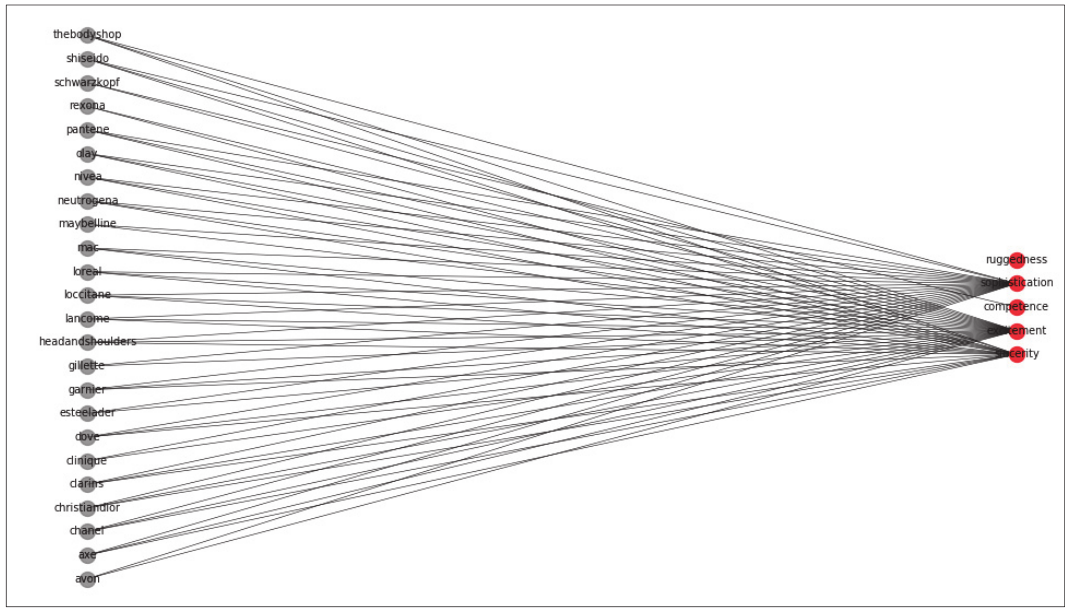
<Figure 5> Bipartite graph linking brands and brand personality